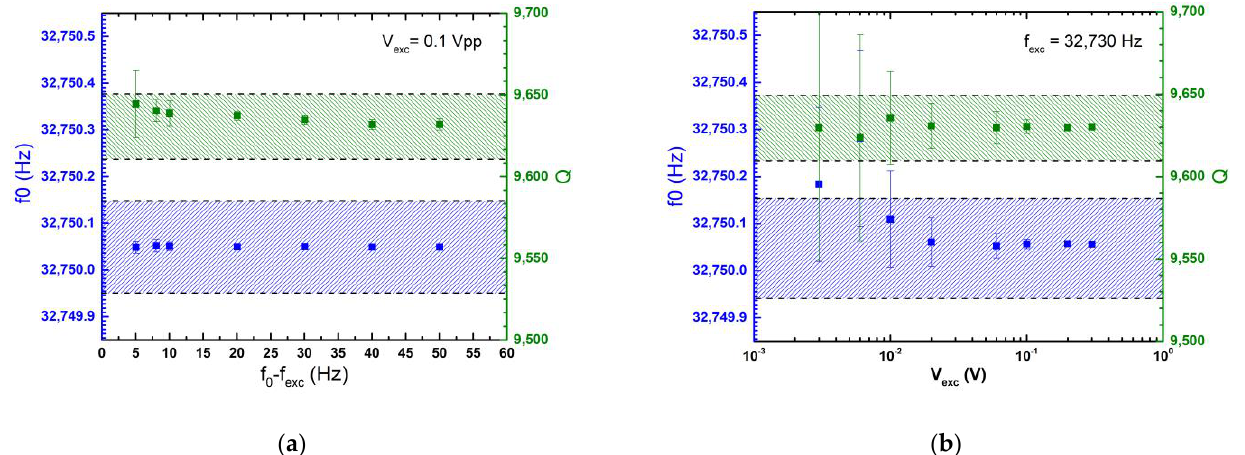
Figure 3. Measured QTF parameters as a function of the excitation frequency ( a ) and the excitation amplitude ( b ). The hatched areas correspond to the target accuracy and the error bars to the standard deviation. The excitation time t exc is set to 200 ms to ensure the QTF is at steady state before the onset of the relaxation.